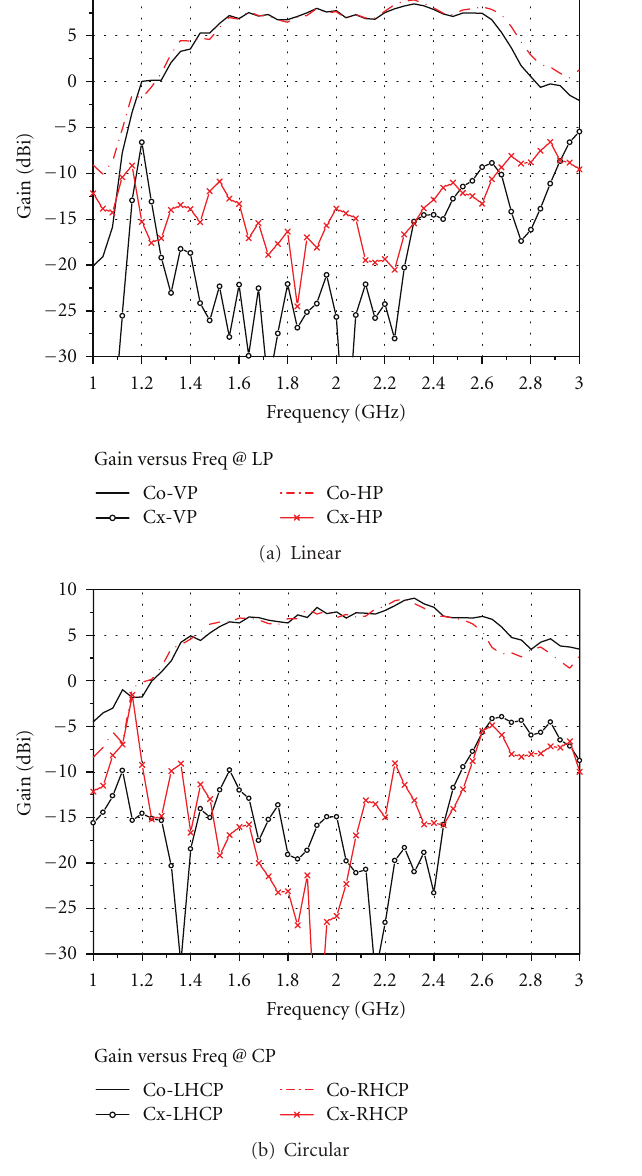
Figure 13: Measured gain performances versus frequency of the BPCDE PR